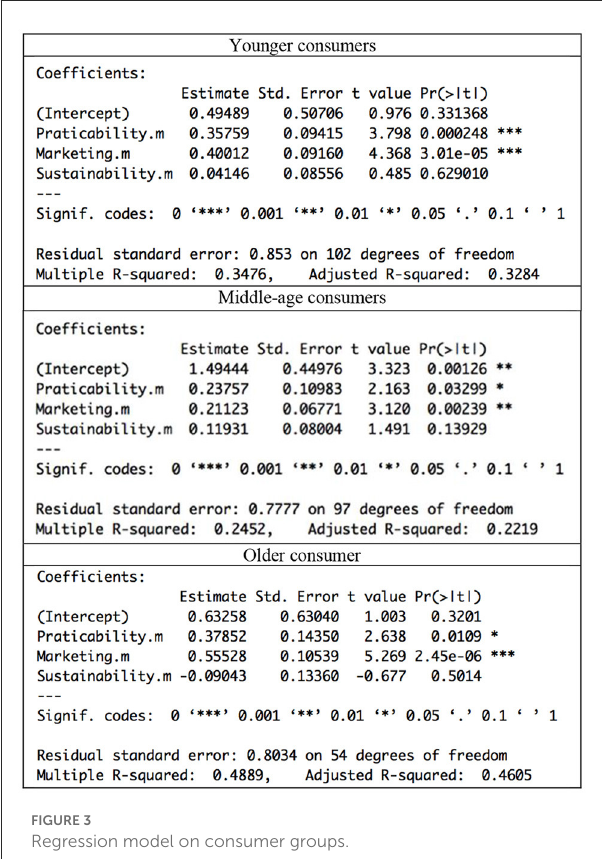
FIGURE3 Regression model on consumer